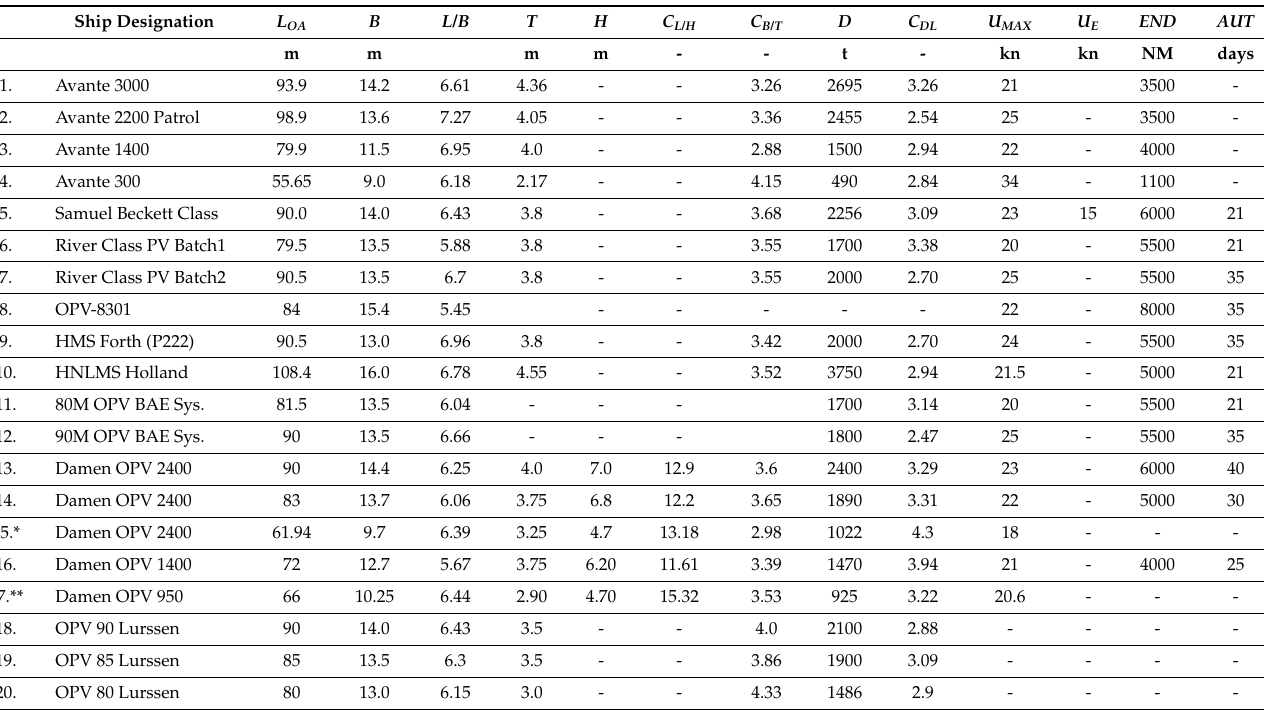
Table A1. Overview of existing OPVs and proposed